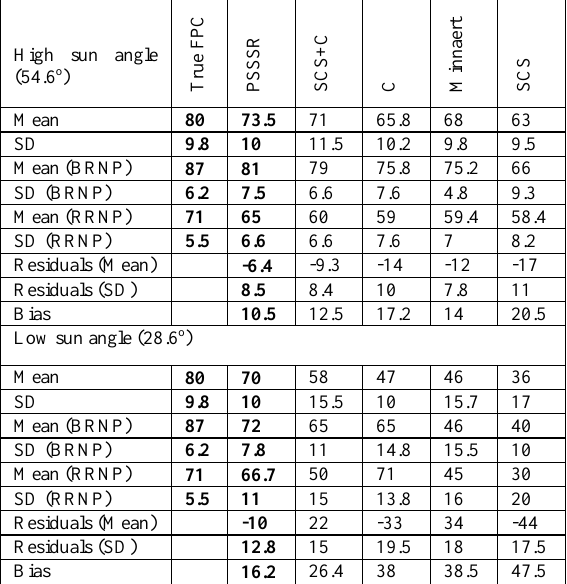
Table.3.Statistics for field measured FPC estimates